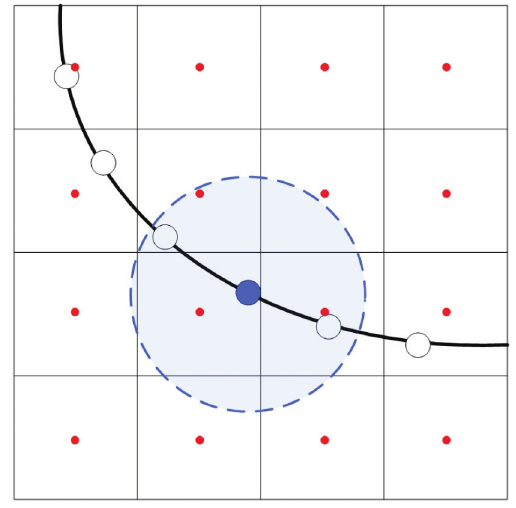
Figure 2 - Immersed geometry on a staggered finite volume computational grid. Distribution of the Lagrangian forces to the Eulerian